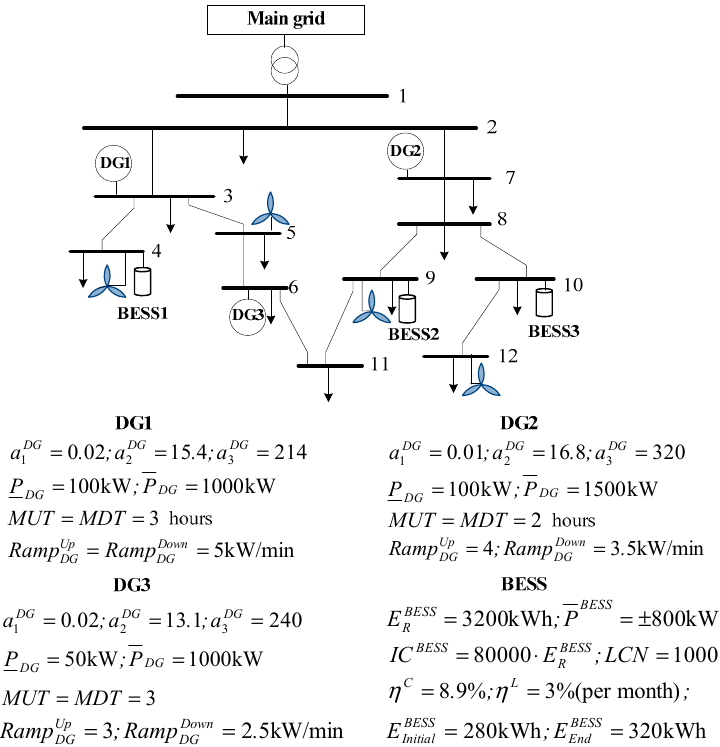
11 of 20 Figure 2. Flow chart of the applied solution algorithm.